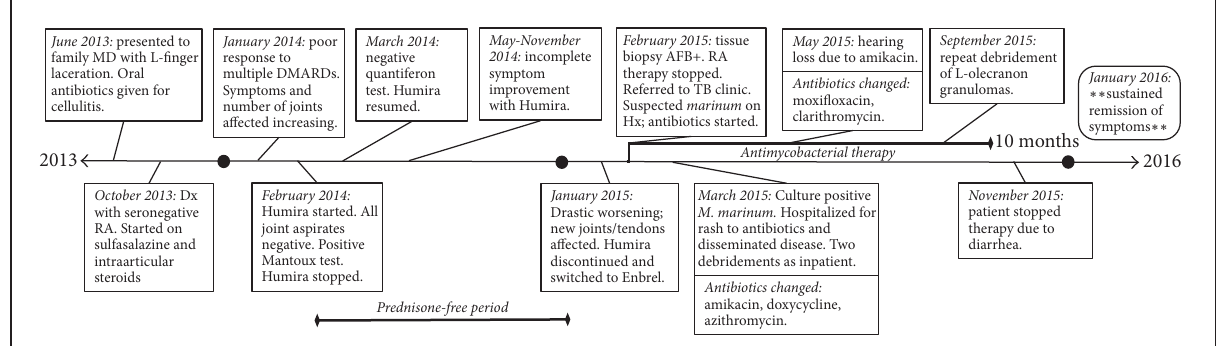
Figure 1: Summary timeline of patient clinical course and treatments.